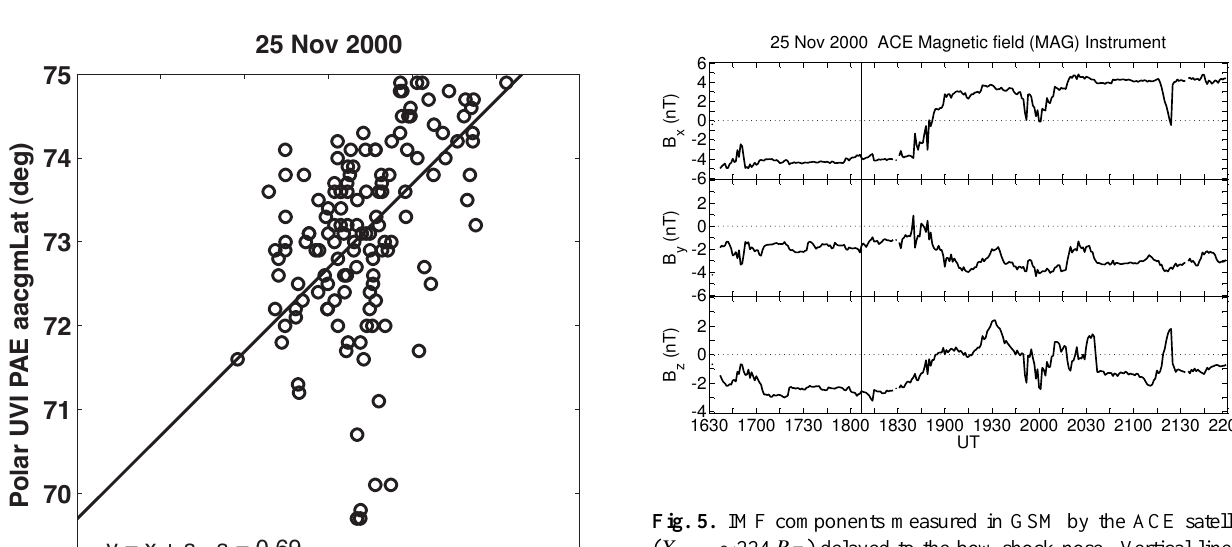
Fig. 5. IMF components measured in GSM by the ACE satellite ( X GSM ∼ 224 R E ) delayed to the bow shock nose. Vertical line at 18:07UT indicates the substorm onset time. See details in the